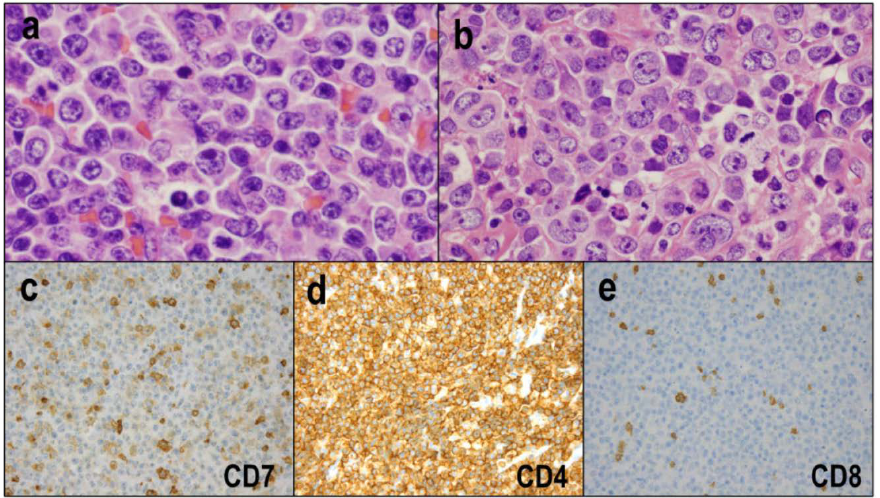
Figure 6. Adult T-cell leukemia/lymphoma. ( a ) Tumor cells are usually medium-to-large and pleomorphic (HE 400). ( b ) Anaplastic-like cells are occasionally present (HE × cells usually lack CD7 expression ( 200). ( d , e ) Most cases are positive for CD4 ( × for CD8 ( ×